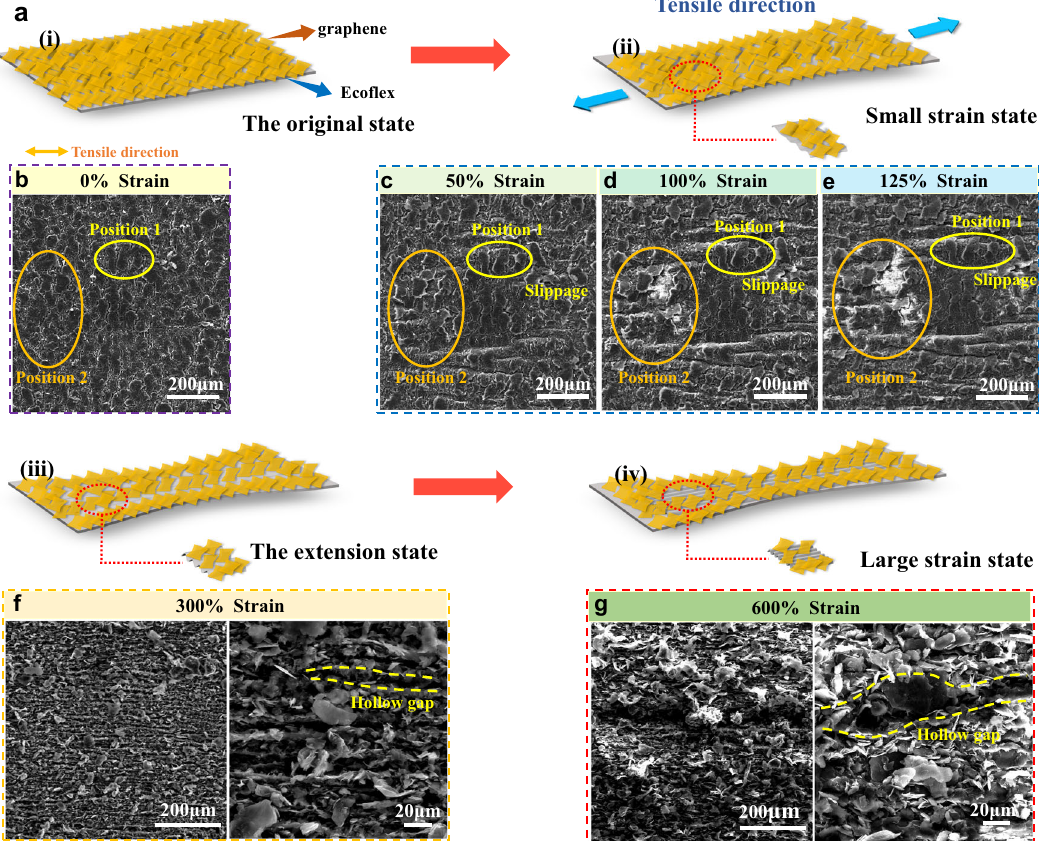
Fig. 3 The resistance sensing mechanism of graphene/Eco fl ex strain sensor. a Schematic illustrations of resistance sensing mechanism of graphene/Eco fl ex strain sensor under a stretching process. Top-view SEM images of graphene/Eco fl ex strain sensor with various strain: b 0%, c 50%, d 100% and e 125% f 300% and g